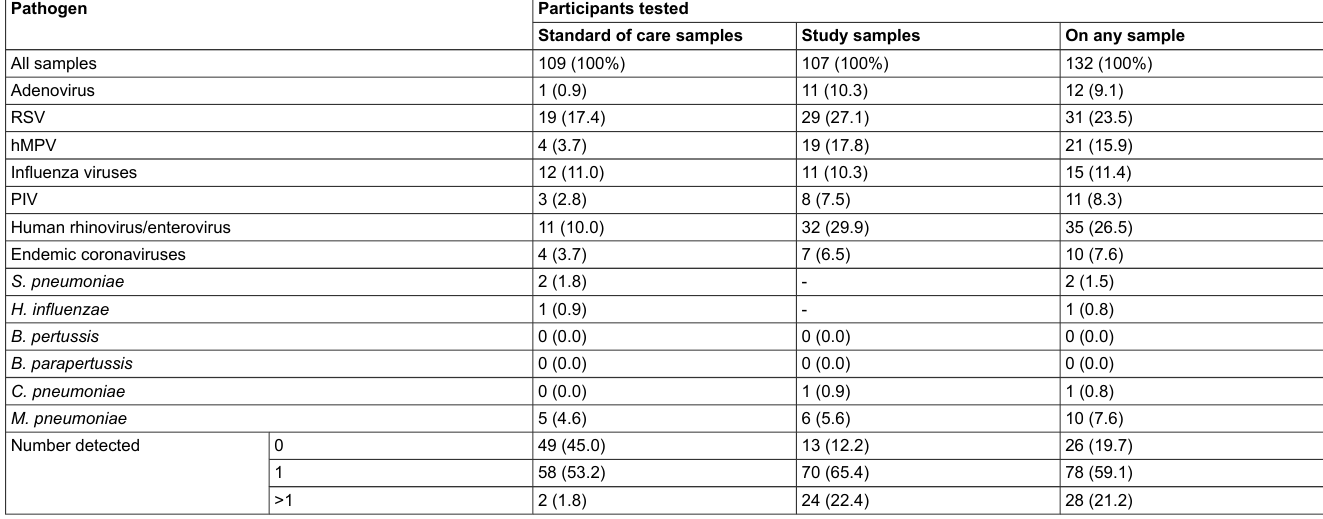
Table 3: Pathogens detected in study participants. S. pneumoniae and H. influenzae were not tested for on study samples; data collected on standard of care samples and pathogens other than RSV, influenza viruses, S. pneumoniae , H. influenzae and M. pneumoniae was collected as free text and may be incomplete – numbers detected should be interpret- ed with